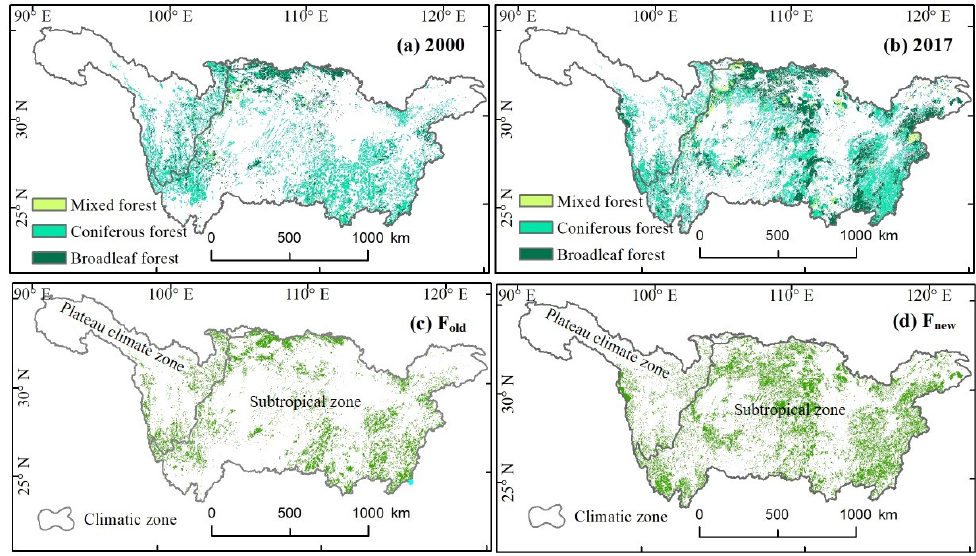
Figure 2. The distributions of ( a ) 2000 forest, ( b ) 2017 forest, ( c ) old forest (F old ), and ( d ) new forest (F new ) in Yangtze River Basin,